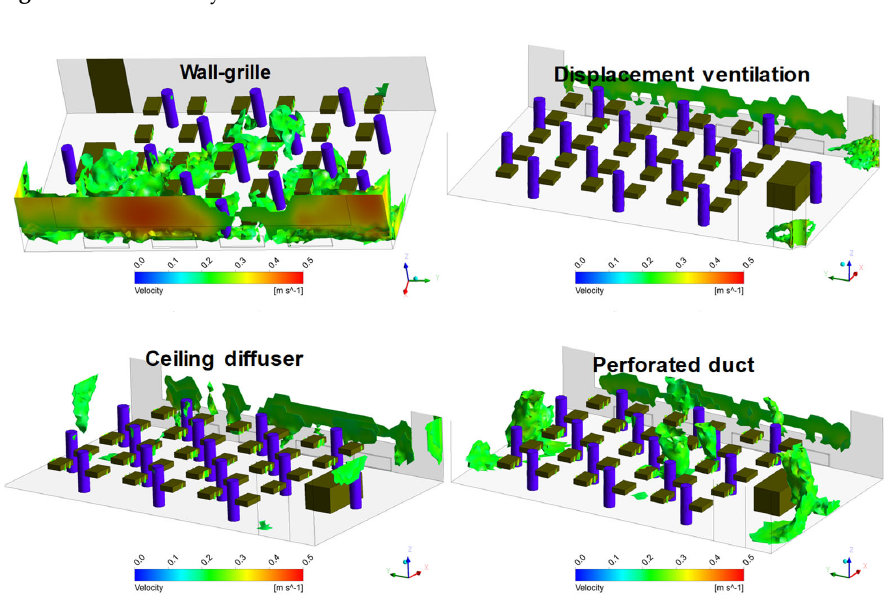
Figure 13. Air velocity distribution in winter. In winter, the air velocity in the occupied zone is both quite low with the displacement terminal unit and ceiling diffuser. The air velocity is higher at the window side with the wall-grille and some parts of the occupied zone with the perforated